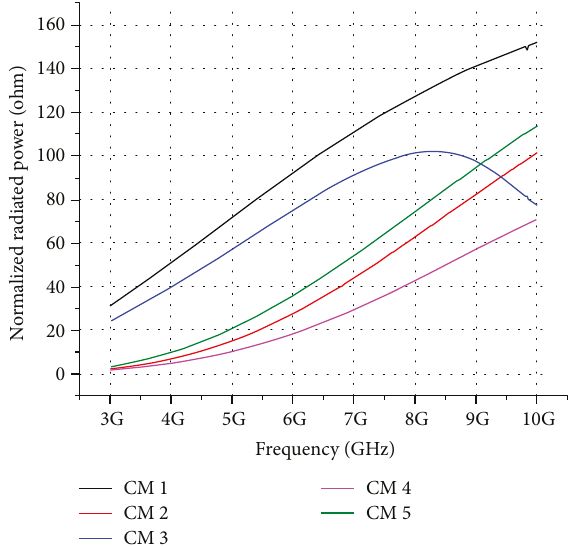
Figure 18: The normalized imaginary powers corresponding to the CMs shown in Figure